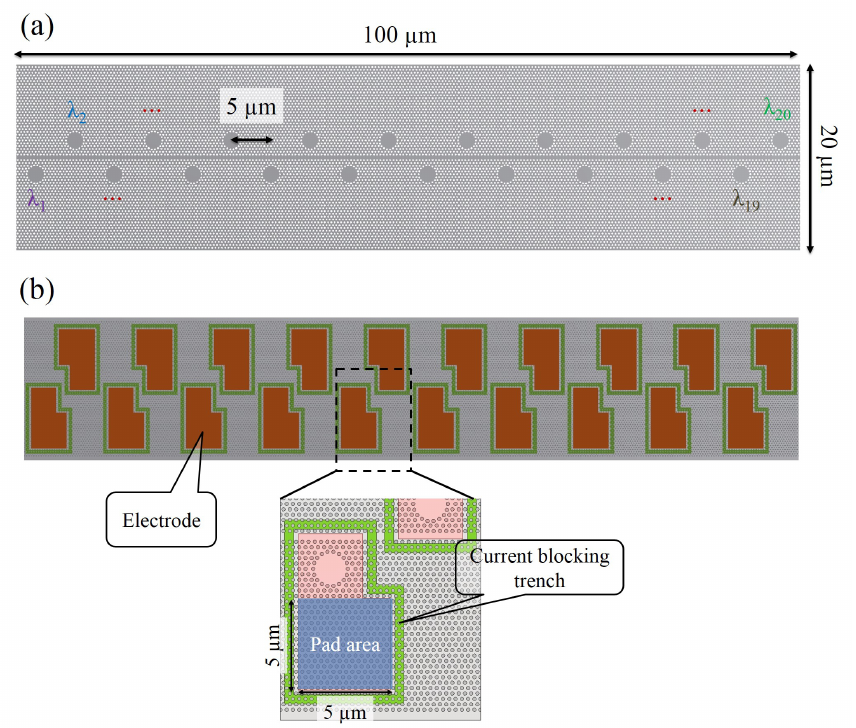
Figure 3. ( a ) Schematic of CirD laser array architecture enabled wavelength division multiplexing (WDM). ( b ) Schematic of CirD laser array in which each cavity is isolated by current blocking trench. 5 µ m × 5 µ m area outside of cavity is used as the bonding